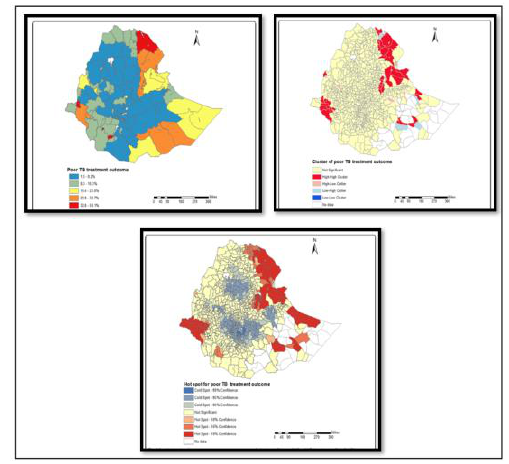
Figure 3 . Mapping Disease of TB (Alene et al.,